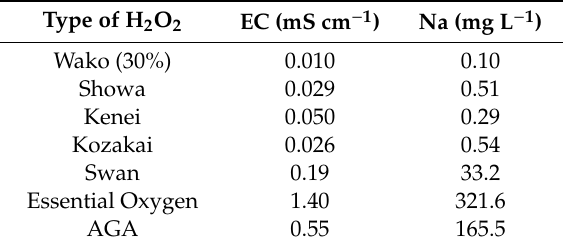
Table 5. EC values and Na concentrations of the di ff erent H 2 O 2 solutions used.